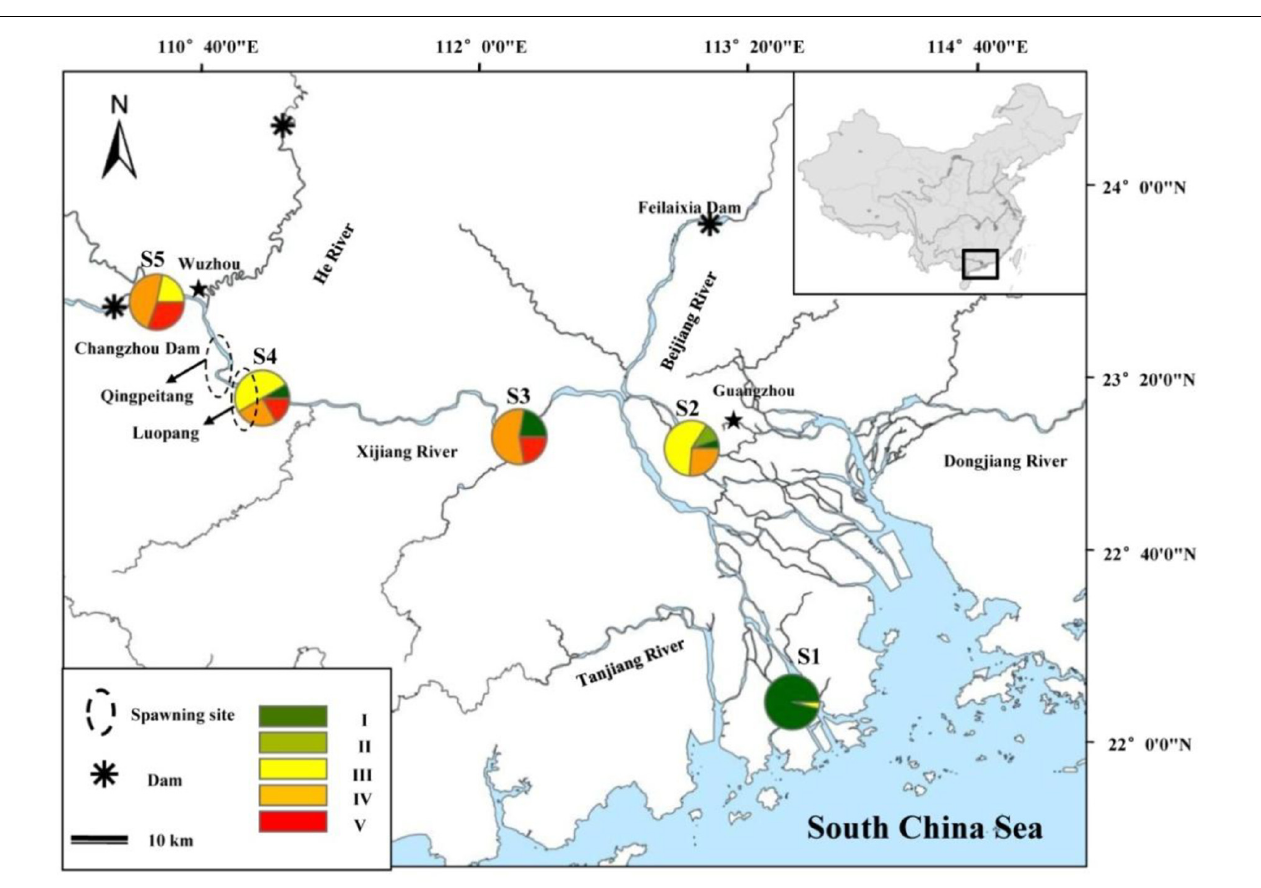
( Figure 2A ). The proximate composition of ovary in each group was closely related to their habitat and biological index ( Figure 2B ). The proximate composition of S4 and S5 groups